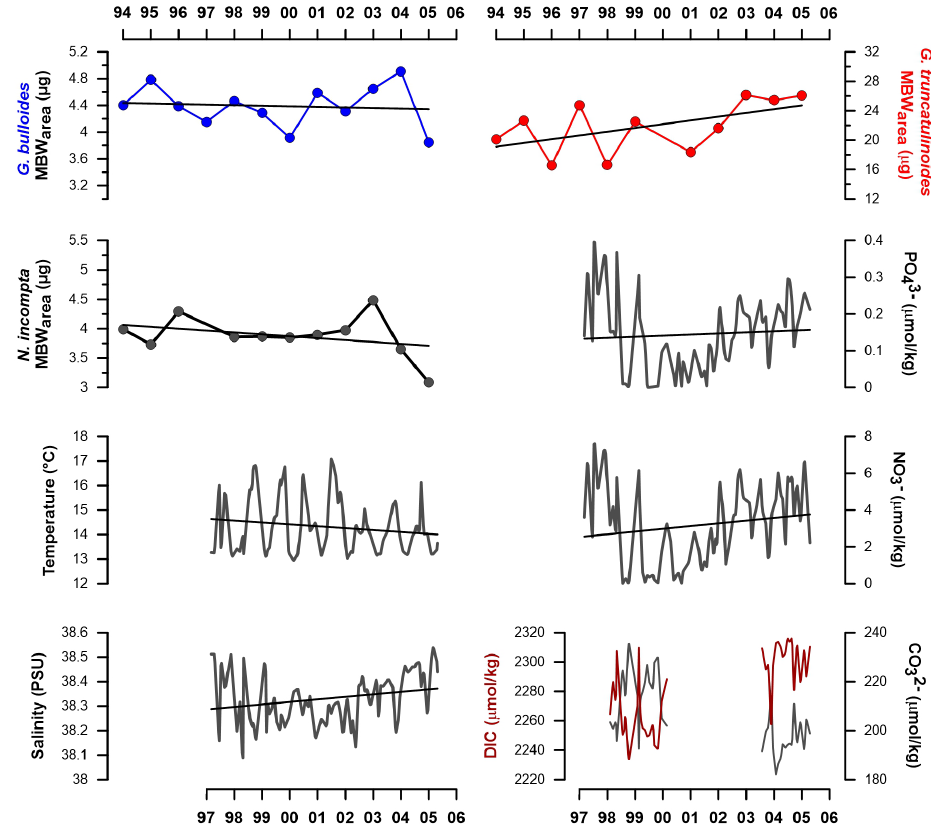
Figure 5. Interannual mean MBW area (µg) values for G. bulloides , N. incompta , and G. truncatulinoides from the high productivity period (see Sect. 2) and Planier and DYFAMED environmental data variations across the record. Black lines represent the trends from the MBW area and resampled data. DIC represents dissolved inorganic